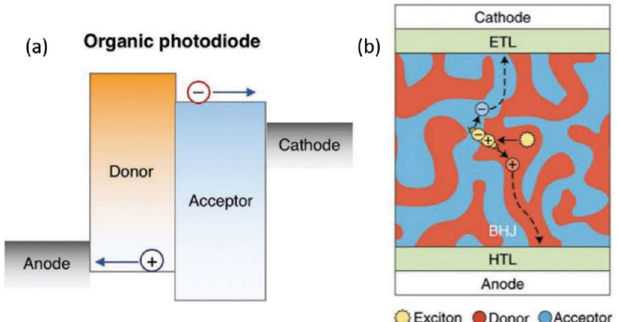
Figure 1. Organic photodetectors. ( a ) Band diagram of an organic photodiode depicting charge separation of excitons at donor–acceptor interface. ( b ) Use of bulk heterojunction (BHJ) structure with nanoscale domains enables optimal harvesting excitons. Reprinted with permission from [20] ©2021 Wiley-VCH